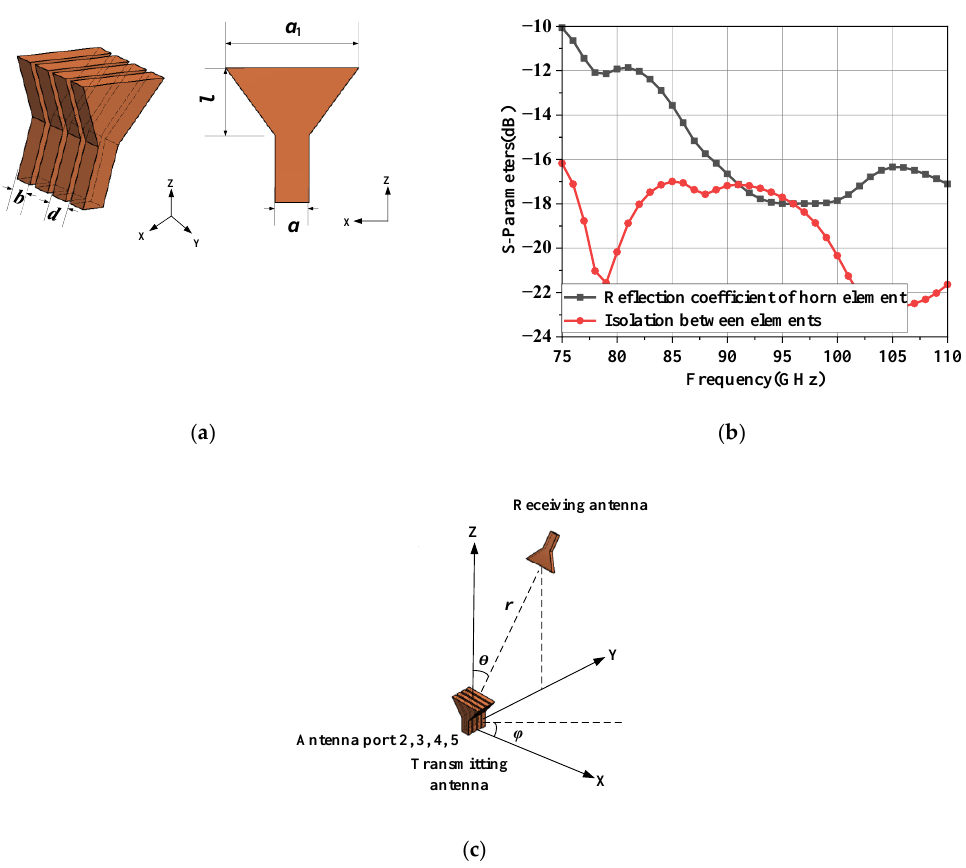
Figure 2. The diagram of ( a ) proposed H-plane horn array antenna ( b = 1.27 mm, d = 1.77 mm, a 1 = 10 mm, l = 5 mm, a = 2.54 mm); ( b ) the simulated reflection coefficient of horn element and simulated isolation between elements; ( c ) the power transmission system.